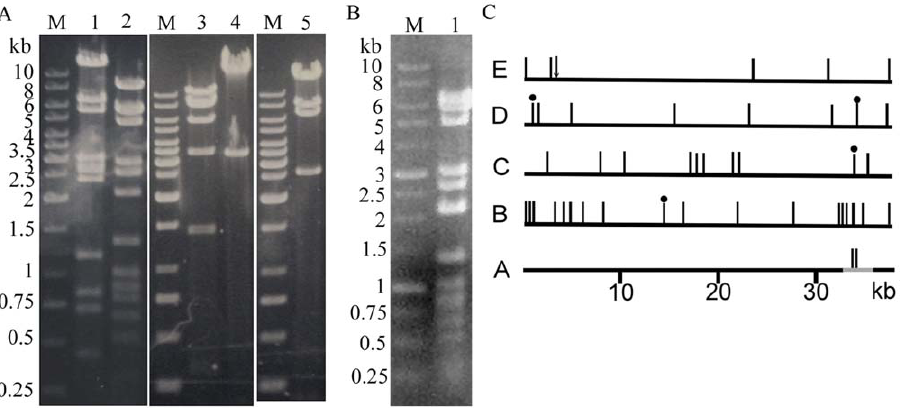
Figure 1. Mapping of the T3/7 and T7M DNA. The genomic DNA was digested by restriction endonucleases, and the fragments were observed by 1% (T3/7) or 0.8% (T7M) agarose gel electrophoresis. M: DNA marker. (A) Digestions of T3/7 DNA. Lane 1, Mbo I; lane 2, Hpa I; lane 3, Nde I; lane 4, Stu I; lane 5, Avr II. The markers are the same for the three slices of gels. (B) Digestion of T7M DNA. Lane 1, Hpa I. (C) Restriction sites in the T3/7 genome. Restriction sites are represented by vertical bars above the DNA. A: The T3 genome (black) and the region replaced by T7 DNA (in grey) in T3/7. The region of recombination is deduced from restriction mapping and sequencing. The two Mbo I sites in T7 that replace the single Mbo I site at T3 nt 34033 are shown by vertical bars. B to E show restriction sites in T3 genome (black); a dot above the bar indicates that the cutting site is present in T3 but not in T3/7. B: Hpa I sites, C: Mbo I sites, D: Nde I sites, E: Avr II cutting positions are indicated by bars, and the single Stu I site is shown by an